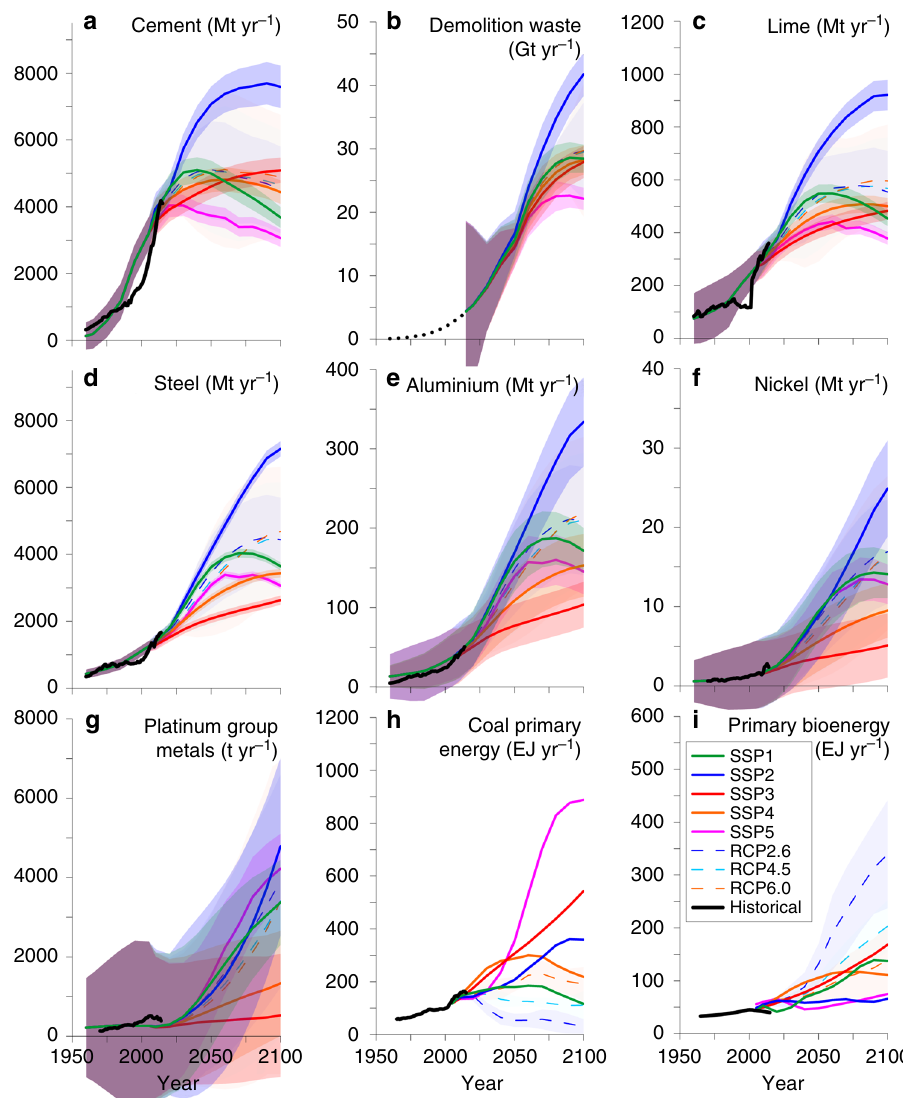
Fig. 2 Production estimates for alkaline materials. a Cement, b demolition waste, c lime, d steel, e aluminium, f nickel, g platinum group metals, h coal primary energy and i primary bioenergy. Historical material production 58 and energy use 49 are also shown. Production forecasts were generated by combining a gross world product-per capita production saturation model, with projections of future economic growth, relative consumption, population and energy